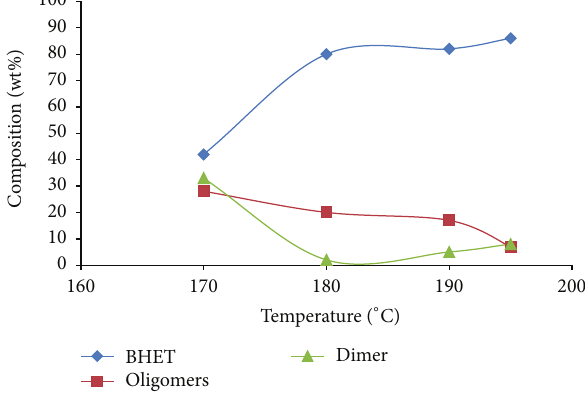
Figure 6: Effect of reaction temperature on distribution of the products (1atm, 8hr, with 4.0 gr of [bmim] Br)